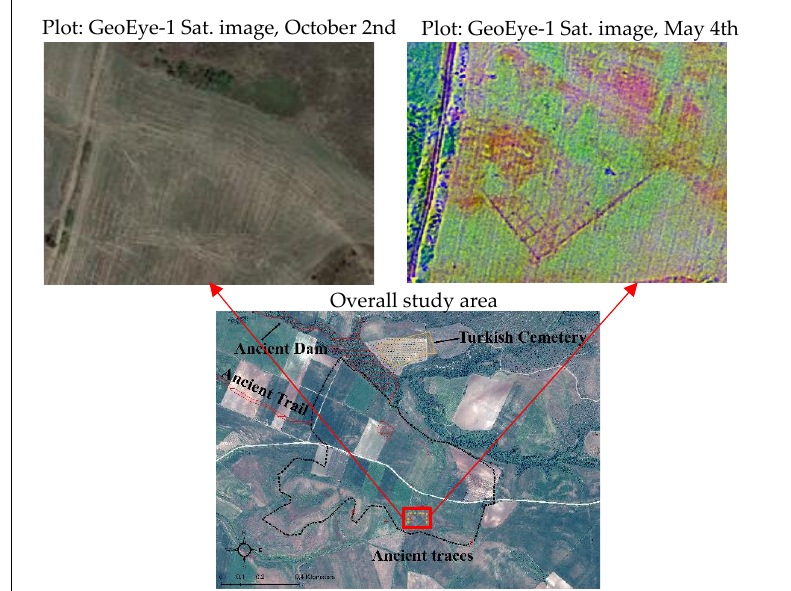
Figure 7. Detection and recording of archaeological traces from multispectral satellite images. Selected zones of the archaeological site were mapped with a UAV from a height of 50 metres. The image below depicts part of the outer wall of an ancient city. With aerial photography from a UAV, an orthomosaic map of the archaeological site was created with a spatial resolution of 5 cm. The resulting product was used in collaboration with archae- ologists to identify a detailed outline of the wall and its buried or damaged parts (Figure 8). Figure 8. Ancient city wall section, mapping from UAV.